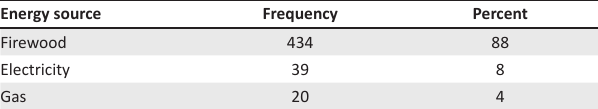
TABLE 1: Energy sources and types.